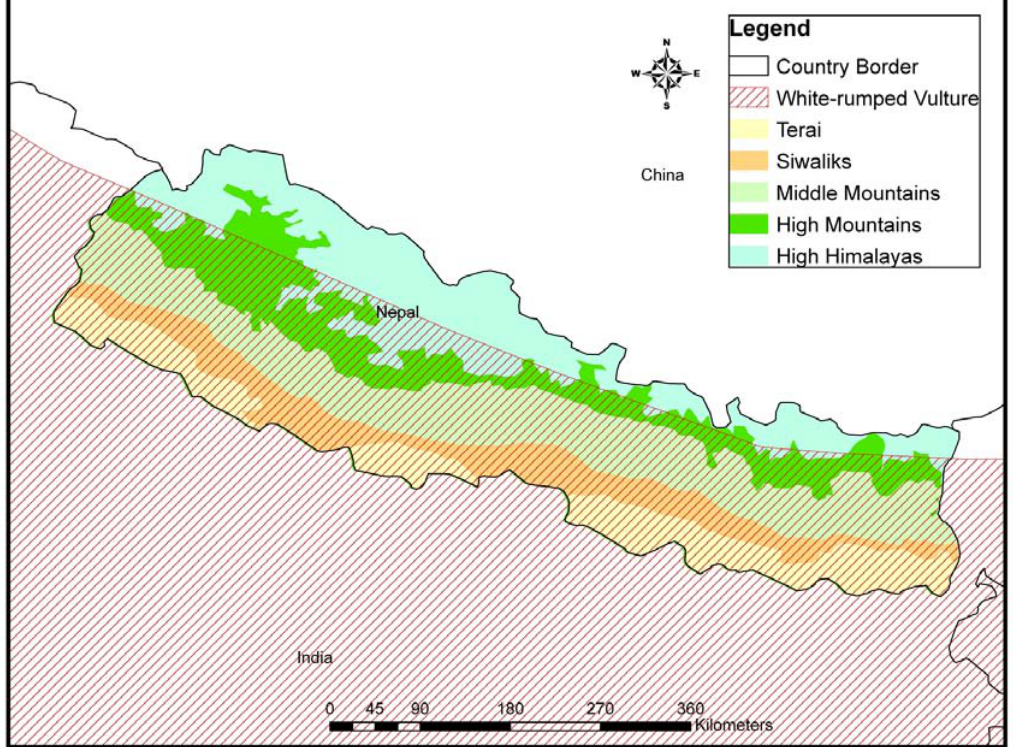
Figure 2. White-rumped Vulture distribution in Nepal. Adapted from (Birdlife International & NatureServe 2011).